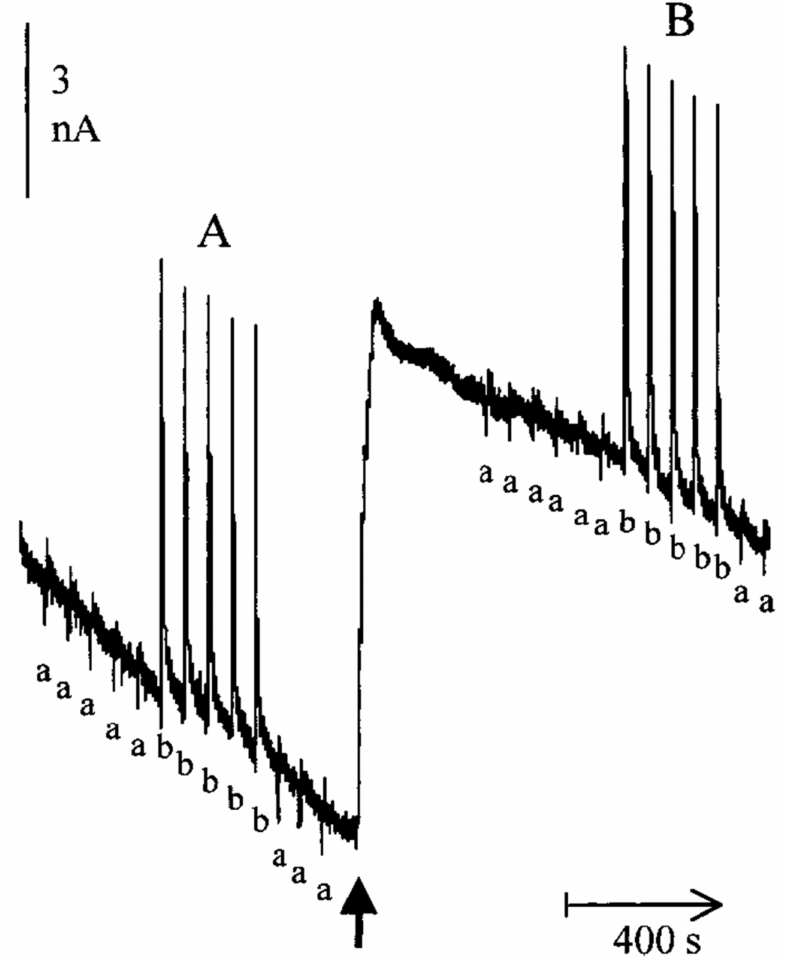
Figure 21. Repetitive Insulin injection response at 0.7 V of chronoamperometry. “a” indicated the blank injections. ( A ) and ( B ) were the response of insulin in the presence of 3 mM and 20 mM glucose, respectively. The other common reagent included phosphate buffer (0.20 M), NaCl (0.15 M). Reprinted with permission from reference [77]. Copyright 2000 American Chemical